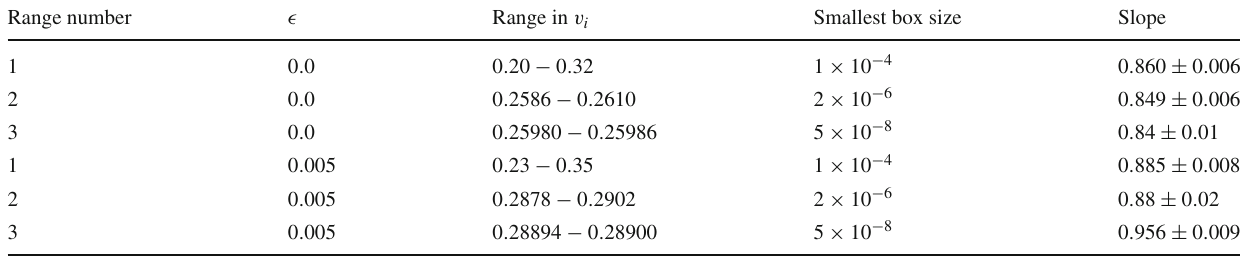
which gives the smallest box size in the table. The range numbers in the table correspond to the labels in Fig. 9. Parameters are γ = 2 . 667 and (cid:8)γ = 2 .